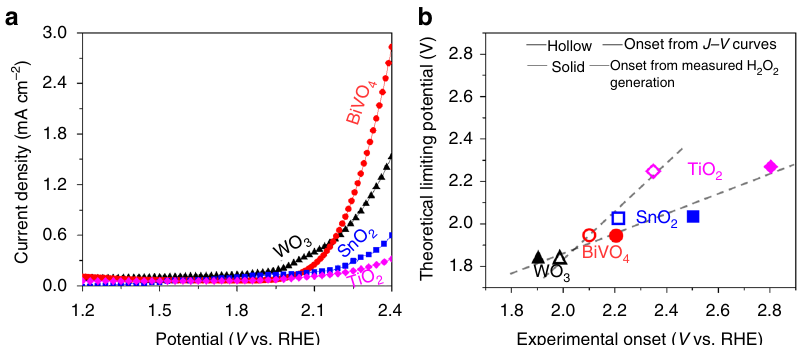
Fig. 2 J – V curves and onset potentials. a J – V curves of four metal oxides without illumination, for which the current onset suggest the onset of H 2 O 2 production. b Theoretical predicted onset potentials vs experimental measured onset potentials for H 2 O 2 production. The values on the y -axis are the theoretical limiting potential obtained from Fig. 1. As to the x -axis, the values of hollow points were the potentials for the J – V curves of different metal oxides to reach 0.2 mA cm − 2 in Fig. 2a, while the values of the solid points were the potentials at which the generated H 2 O 2 concentration reaches 1 ppm, by measuring a 1 cm 2 sample in the 20 ml electrolyte for The corresponding equilibrium potentials for each reaction have been shown in dashed lines.